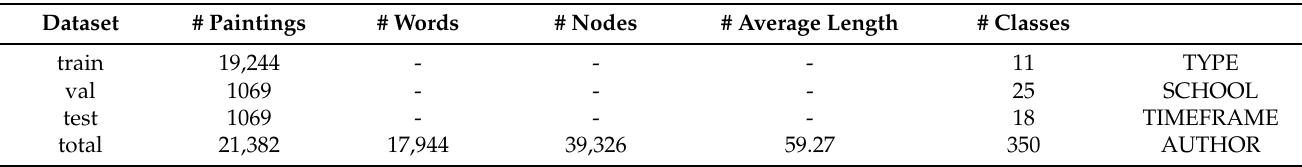
Figure 3. Paintings from the dataset adopted in this work. Each row contains samples from a different artist. The color coding represents different styles. Table 1. Dataset characteristics, including the number of categories in the different classification tasks based on the paintings in the training